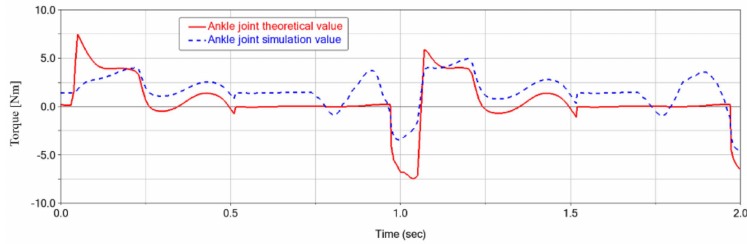
Figure 26. Knee joint torque change rule diagram.